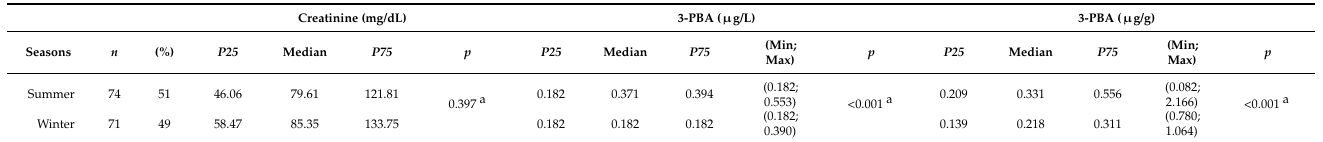
Table 3. Levels of creatinine and 3-PBA with and without adjustment of creatinine in winter and summer samples.